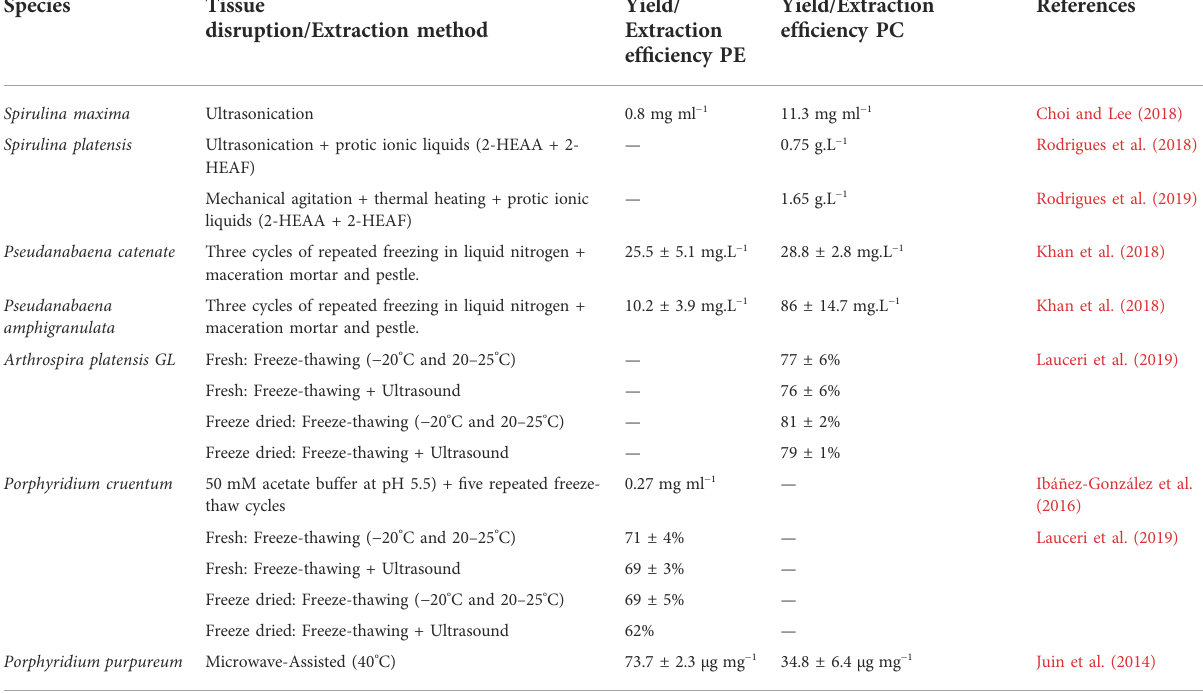
TABLE 3 Extraction methods applied so far to the recovery of phycobiliproteins from microalgae and cyanobacteria.